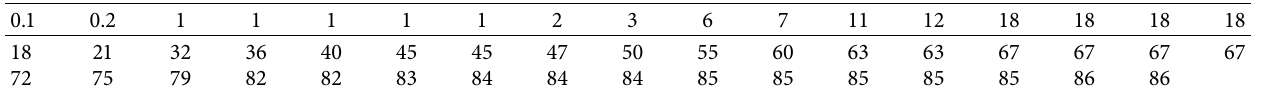
Figure 2: Trace plot of the posterior samples (length is 10 4 ) of λ (left), c (middle), and θ (right) obtained using DE-M-H algorithm (top) and RW-M-H algorithm (bottom) for a randomly selected sample of size n � 100 when λ � 0 . 5, c � 0 . 5, and θ � 1 . 5. Table 9: Failure time of 50